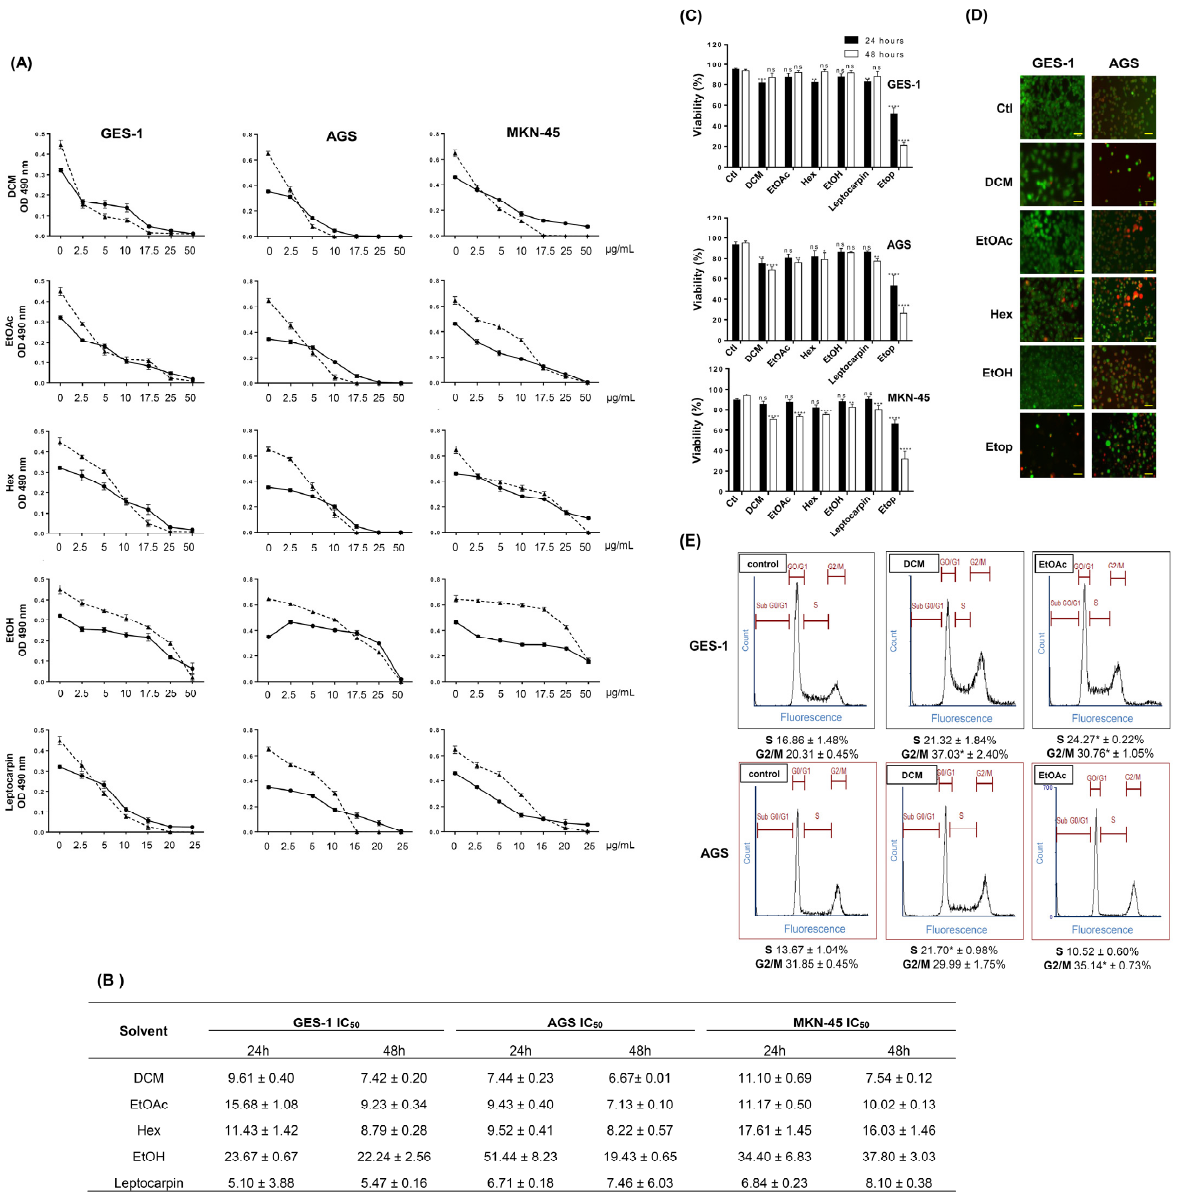
Figure 1. Antiproliferative effect of L. rivularis flower extracts on gastric cell lines. ( A ) Gastric cancer (AGS and MKN-45) and the normal immortalized (GES-1) cell lines were treated with different concentrations of extracts (0, 2.5, 5, 17.5, 25, and 50 µg/mL) or leptocarpin (0, 2.5, 5, 10, 15, 20, and 25 µg/mL) for 24 h (circles) or 48 h (triangles), respectively. Proliferation was evaluated with the MTS assay. Curves represent the absorbance readings at 490 nm from at least three independent experi- ments (means ± S.D.). ( B ) The table shows the half-maximal inhibitory concentration (IC 50 ) calculated for each extract (DCM, EtOAc, Hex, and EtOH) or leptocarpin treatments in GES-1, AGS, and MKN-45 cells, using a fitted second-order polynomial curve (means ± S.D., n = 3). ( C ) GES-1, AGS, and MKN-45 cells were treated with DCM 5 µg/mL, EtOAc 5 µg/mL, Hex 10 µg/mL, EtOH 15 µg/mL, Etoposide (Etop 50 µM), or leptocarpin 5 µg/mL for 24 h (black bars) and 48 h (white bars). Cell viability was evaluated using the trypan blue exclusion assay. Bars represent the percentage of living cells identified as trypan blue-negatives, compared with untreated cells (means ± S.D., n = 3,